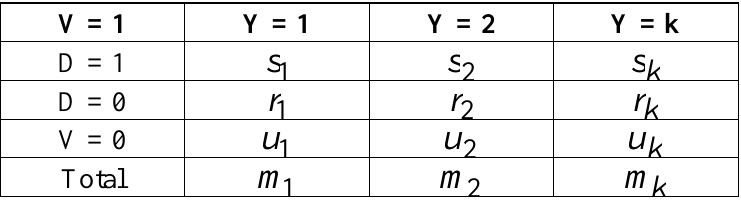
Table 15. Verification bias and one ordinal